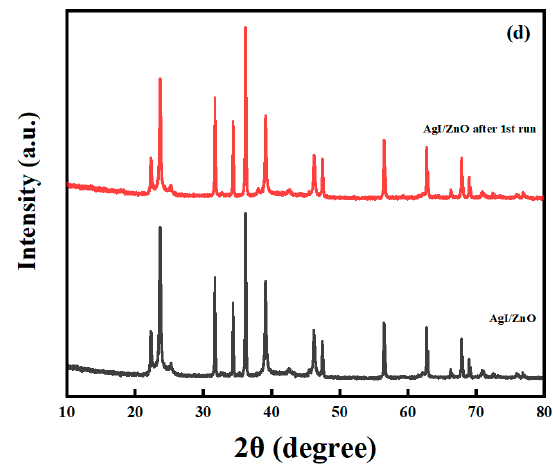
Figure 18. ( a , c ) Circling runs of MNZ photodegradation in the presence of the photocatalysts Ag / ZnO (100:1) and AgI / ZnO (X = 0.4); ( b , d ) XRD patterns of photocatalysts Ag / ZnO (100:1) and AgI / ZnO (X = 0.4) before and after MNZ photodegradation under simulated sunlight irradiation. MNZ’s initial concentration is 2 mg L − 1 , photocatalyst dosage is 0.1 g L − 1 .